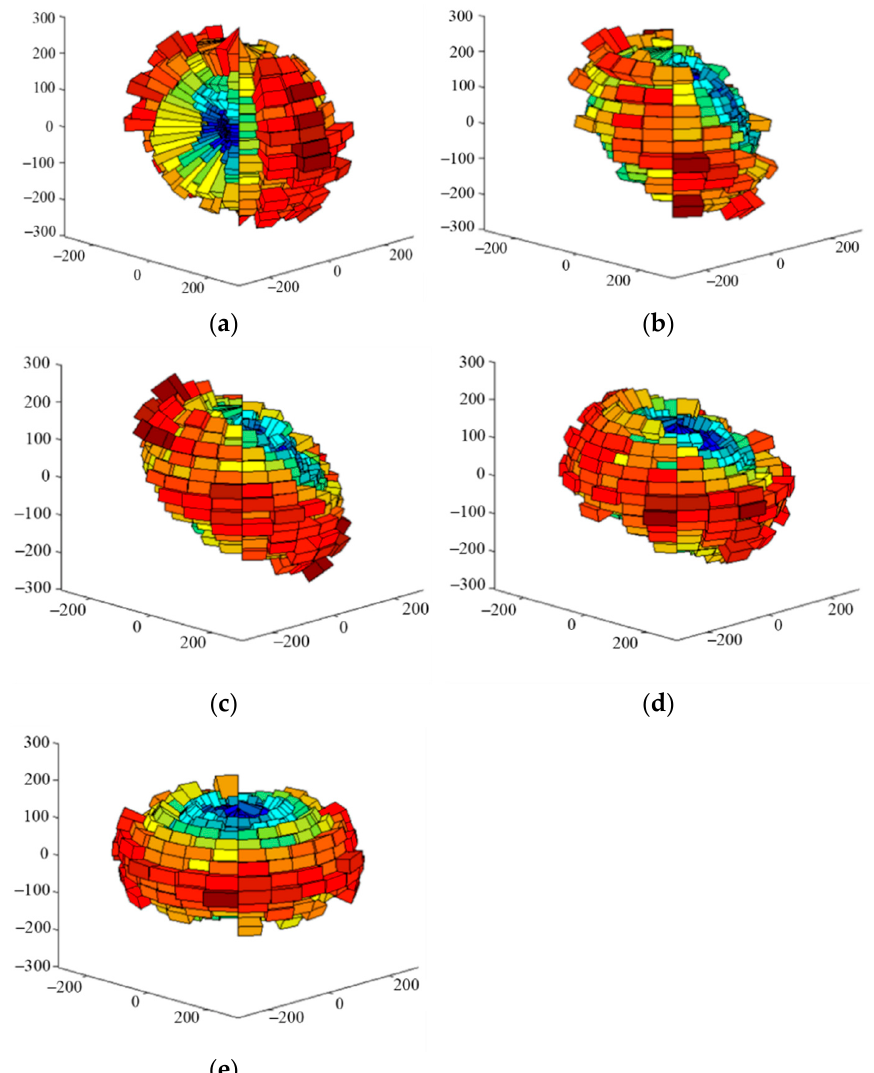
Figure 4. Generating initial anisotropic specimens.